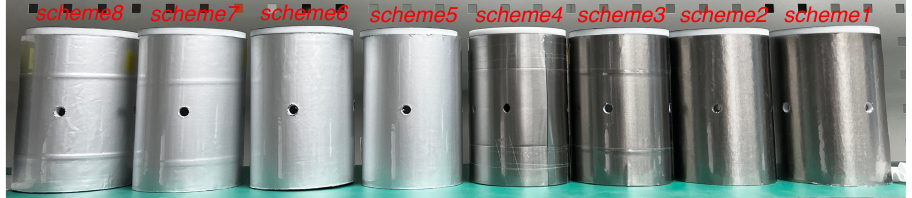
Figure 2. Amorphous and nanocrystalline inner magnetic shield